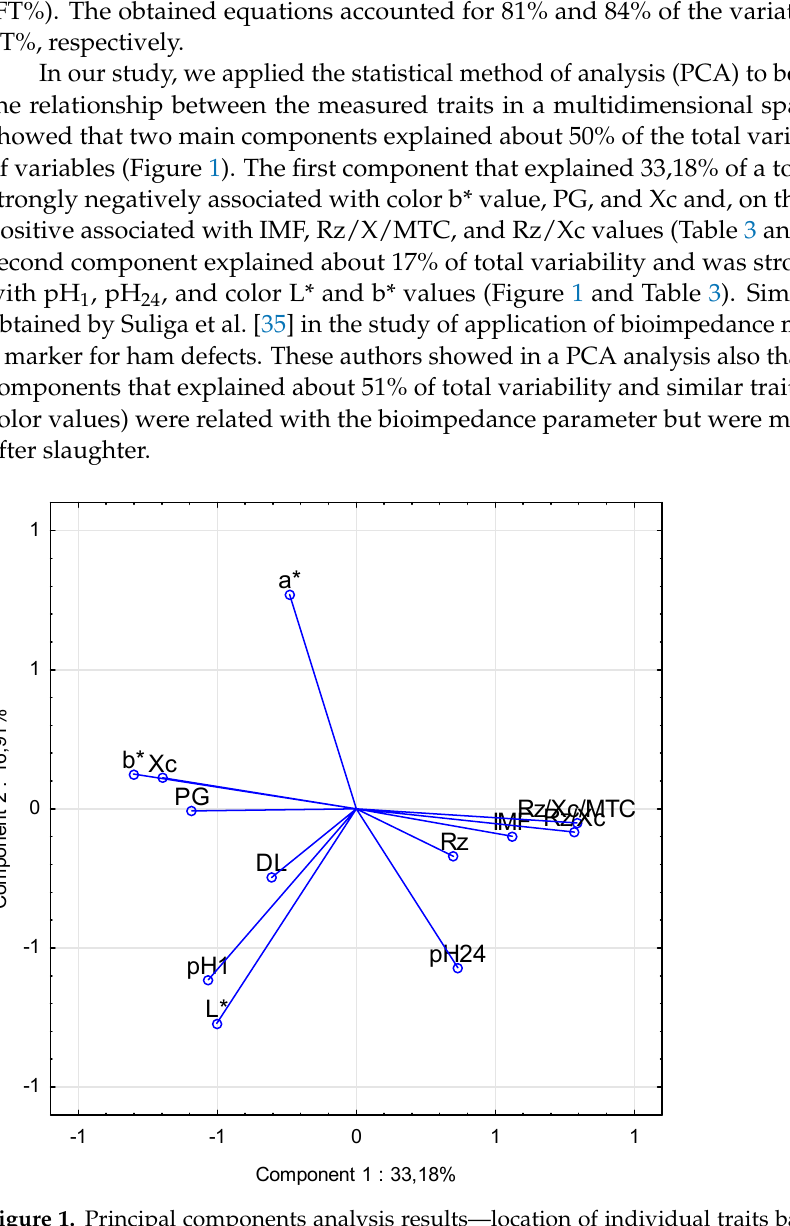
Figure 1. Principal components analysis results—location of individual traits based on their relationship with each other and principal components. Rz = resistance (ohm); Xc = reactance (ohm); HCW = hot carcass weight (kg); DL-drip loss; PG, glycolytic potential; IMF, intramuscular fat. Table 3. Factor coordinates of variables with respect to principal components based on correlation.